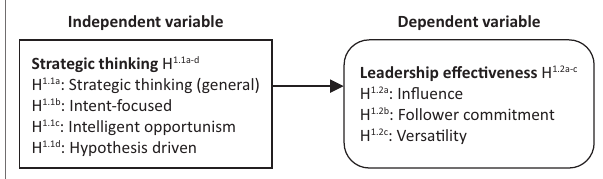
FIGURE 2: The revised hypothesised model of the relationship between strategic thinking competency and leadership